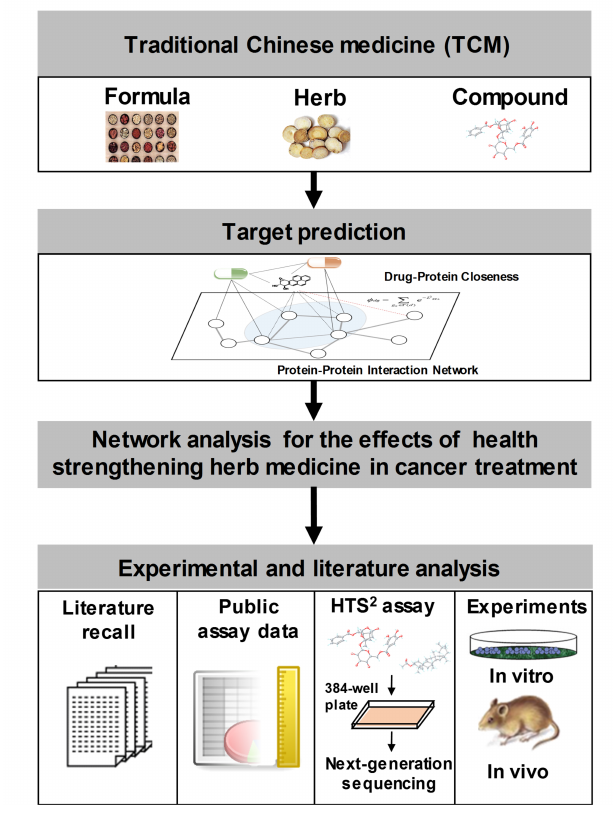
Figure 6. The network analysis workflow for understanding the effects of health-strengthening medicine compounds in cancer